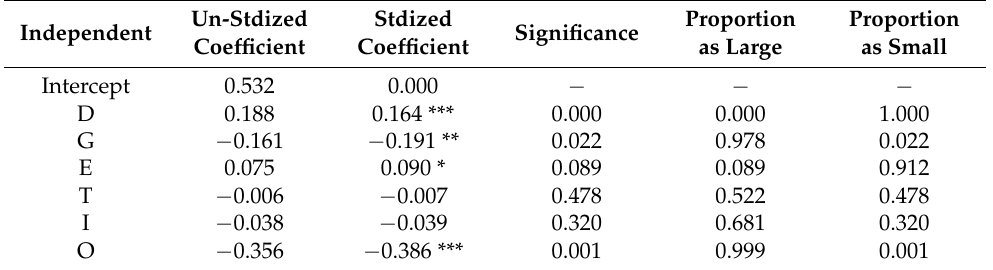
Table 7. Results of the regression analysis between the influencing factors and IGGE (2020). Independent Coefficient